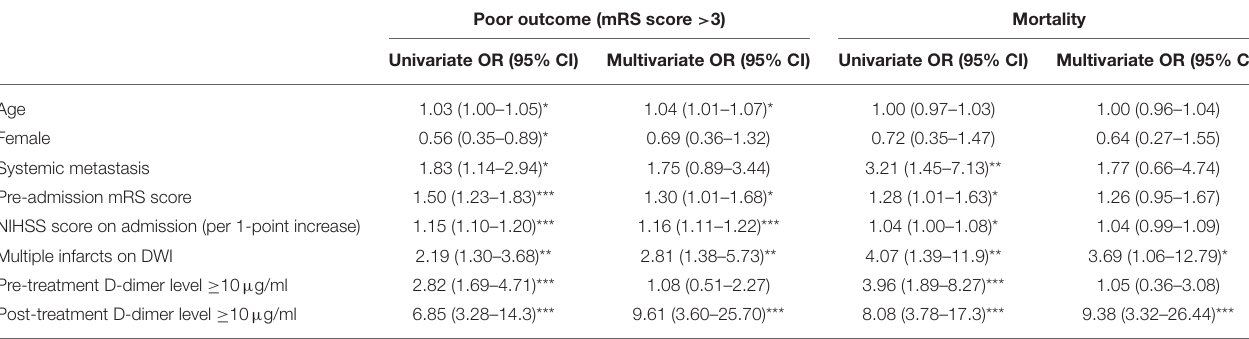
TABLE 3 | Univariate and multivariate regression analyses for poor outcomes and mortality 30 days after admission.